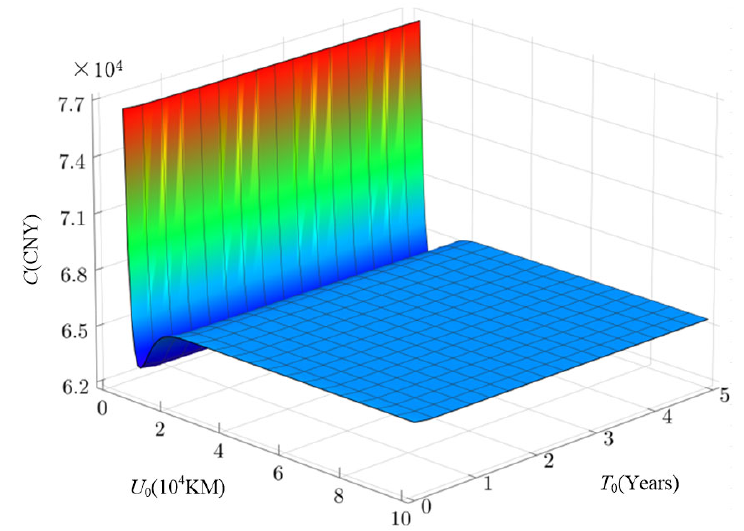
Figure 4. System expected cost rate change.